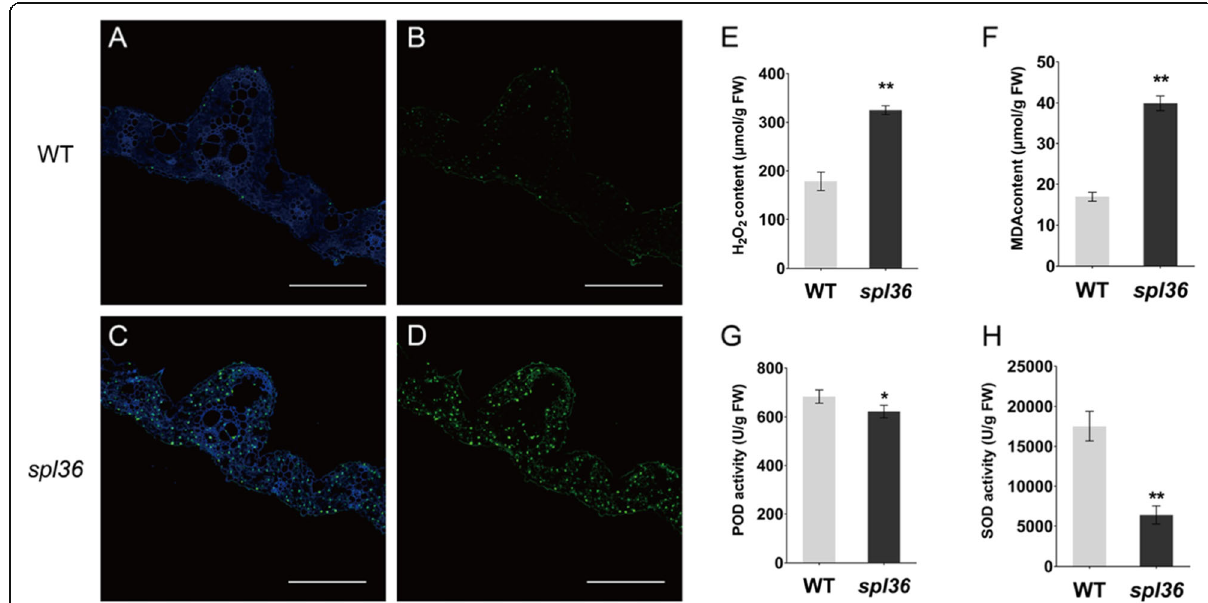
Fig. 3 Physiological and biochemical analysis of wild-type and mutant plants. a- d TUNEL assay of DNA fragmentation in mesophyll cells. Bar = 100 μ m. e-f H 2 O 2 and MDA contents of leaves in spl36 and WT plants at the heading stage. g- h POD and SOD activities in the leaves spl36 and WT plants at the heading stage. POD: peroxidase; SOD: superoxide dismutase; MDA: malondialdehyde; WT: wild